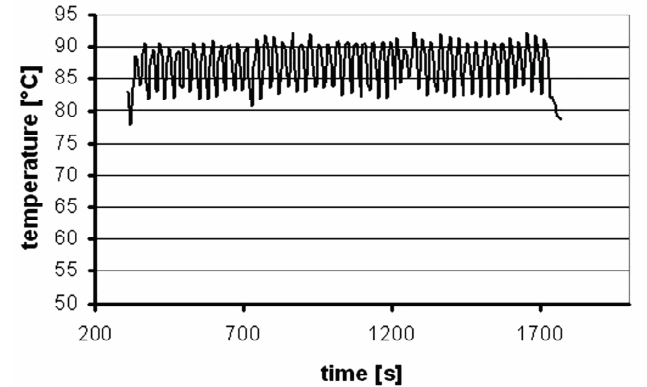
Figure 2. Variation of the temperature at the reactor outlet t out at t t = 86 °C.